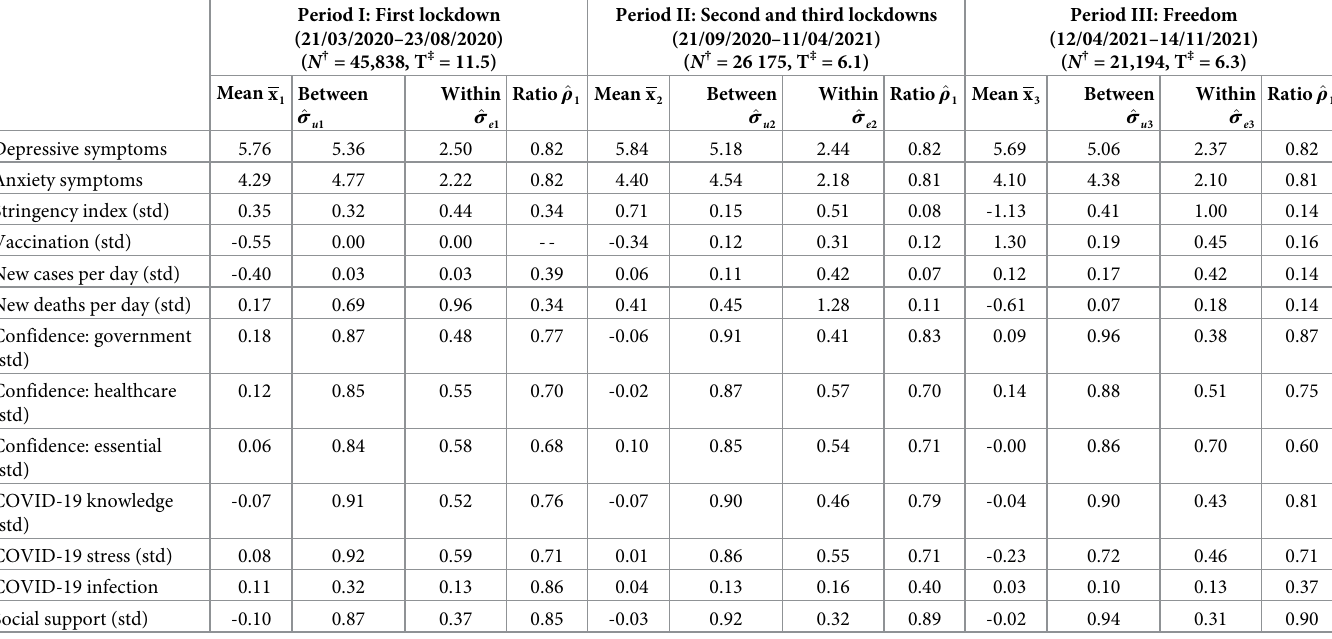
Table 1. Descriptive statistics of time-varying variables across 3 periods